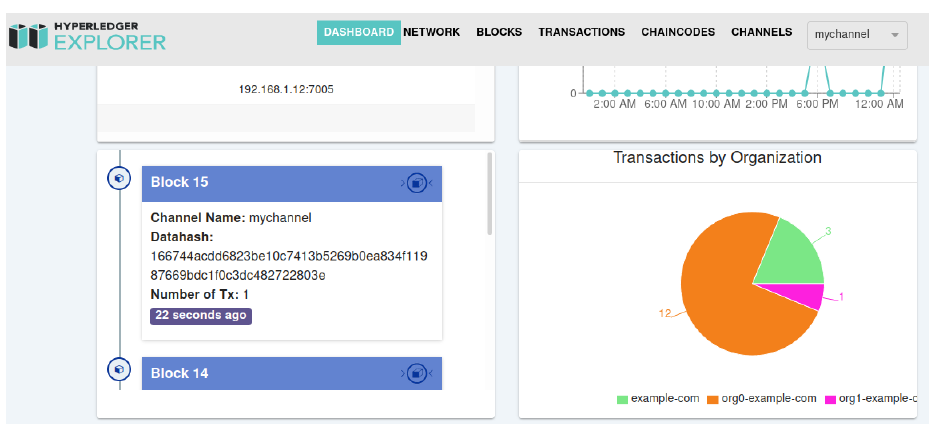
Figure 9. Dashboard 2 smart-contract